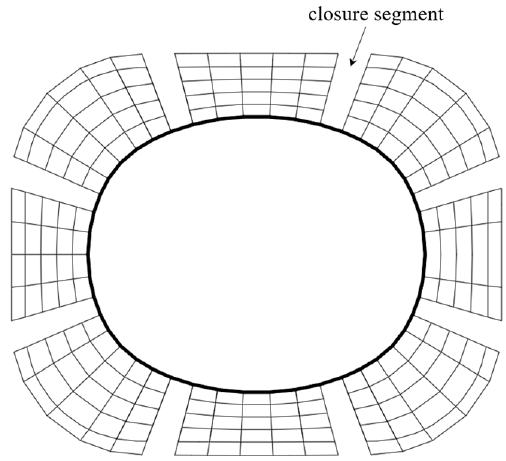
Figure 4. Position of upper-grid closure segments.